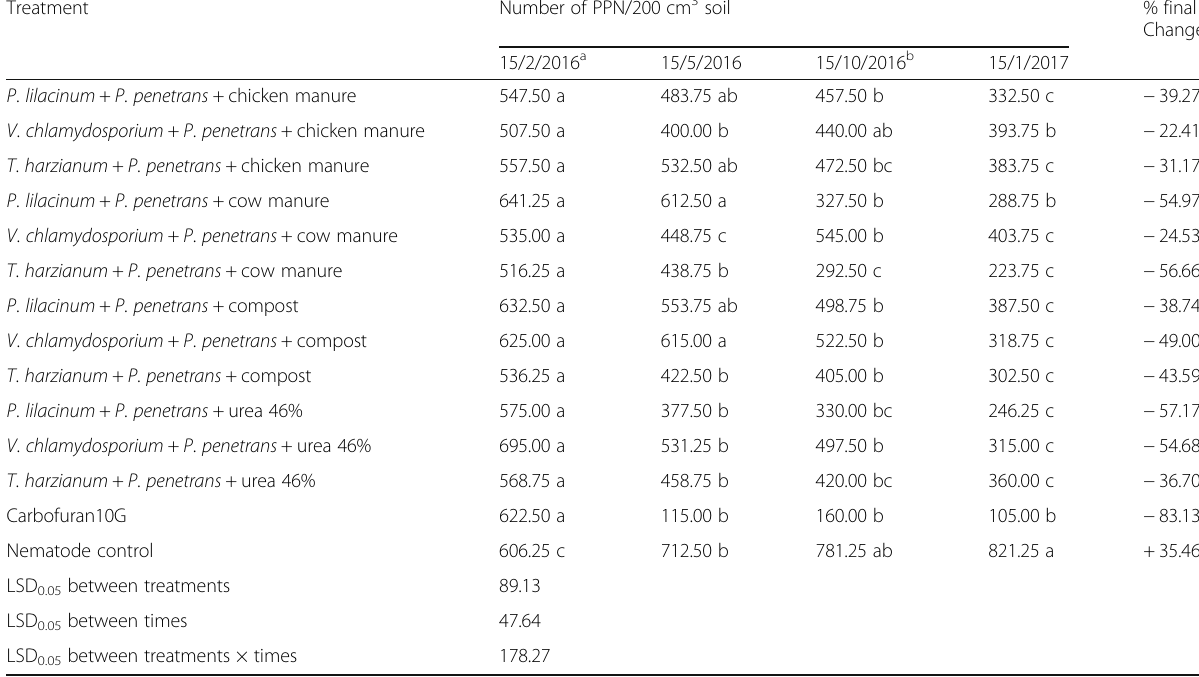
Table 3 Effect of different combinations of integrated control measures on the number of plant-parasitic nematodes (PPN) associated with fig, Ficus carica , rhizosphere